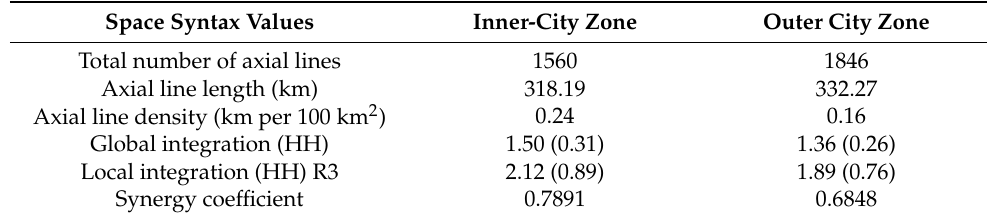
Table 1. Mean values and standard deviations ( SD, in parentheses ) of space syntax for the study area .